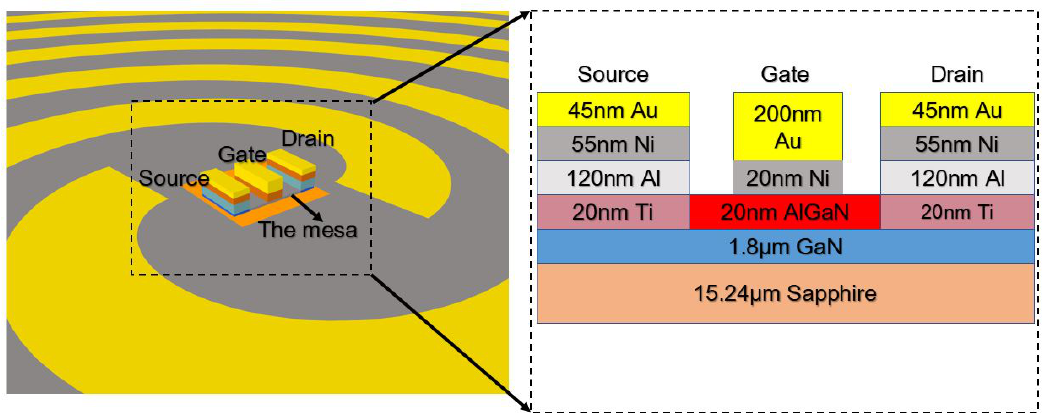
Figure 2. Simulation model of slot-spiral antenna integrated with FET ( left ) and specific parameters of transistor ( right